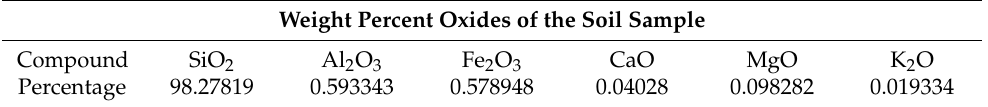
Figure 2. XRD of sand the corresponds to Quartz mineral (blue) and trace amount of other minerals. Table 1. XRF results for the sand.